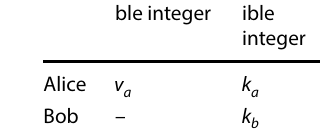
Table 2 The integers used in the protocol